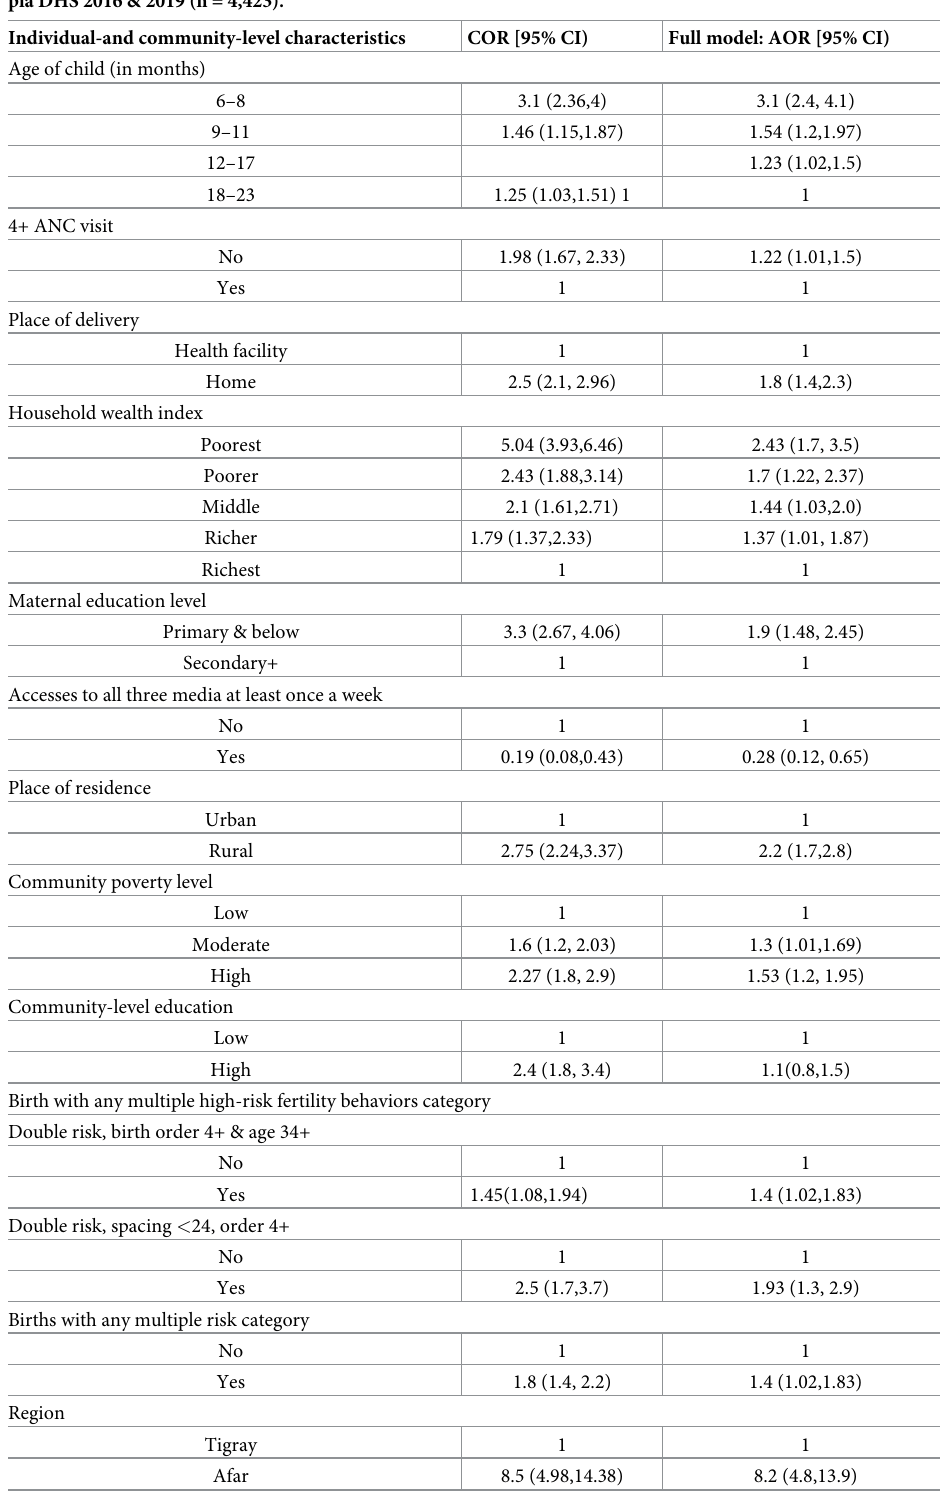
Table 3. Multilevel mixed-effects logistic regression modeling of individual- and community-level factors associ- ated with no ASF consumption among children aged 6–23 months in Ethiopia, based on pooled data from Ethio- pia DHS 2016 & 2019 (n =